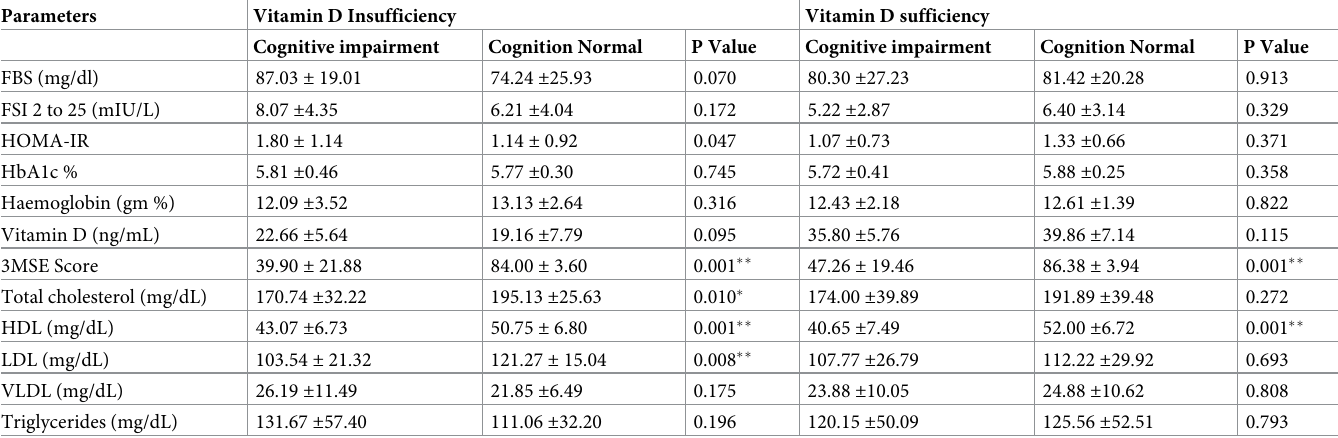
Table 3. Comparison of various parameters among non-diabetic subjects with vitamin D insufficiency and cognitive impairment. Parameters